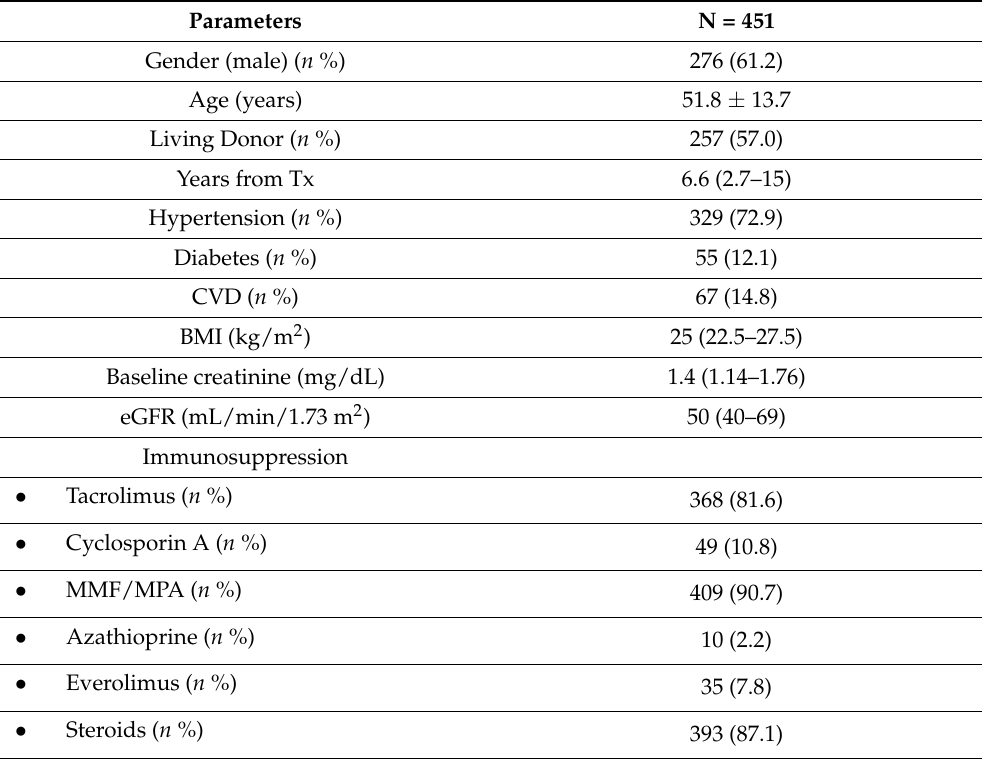
Table 1. Baseline characteristics of study